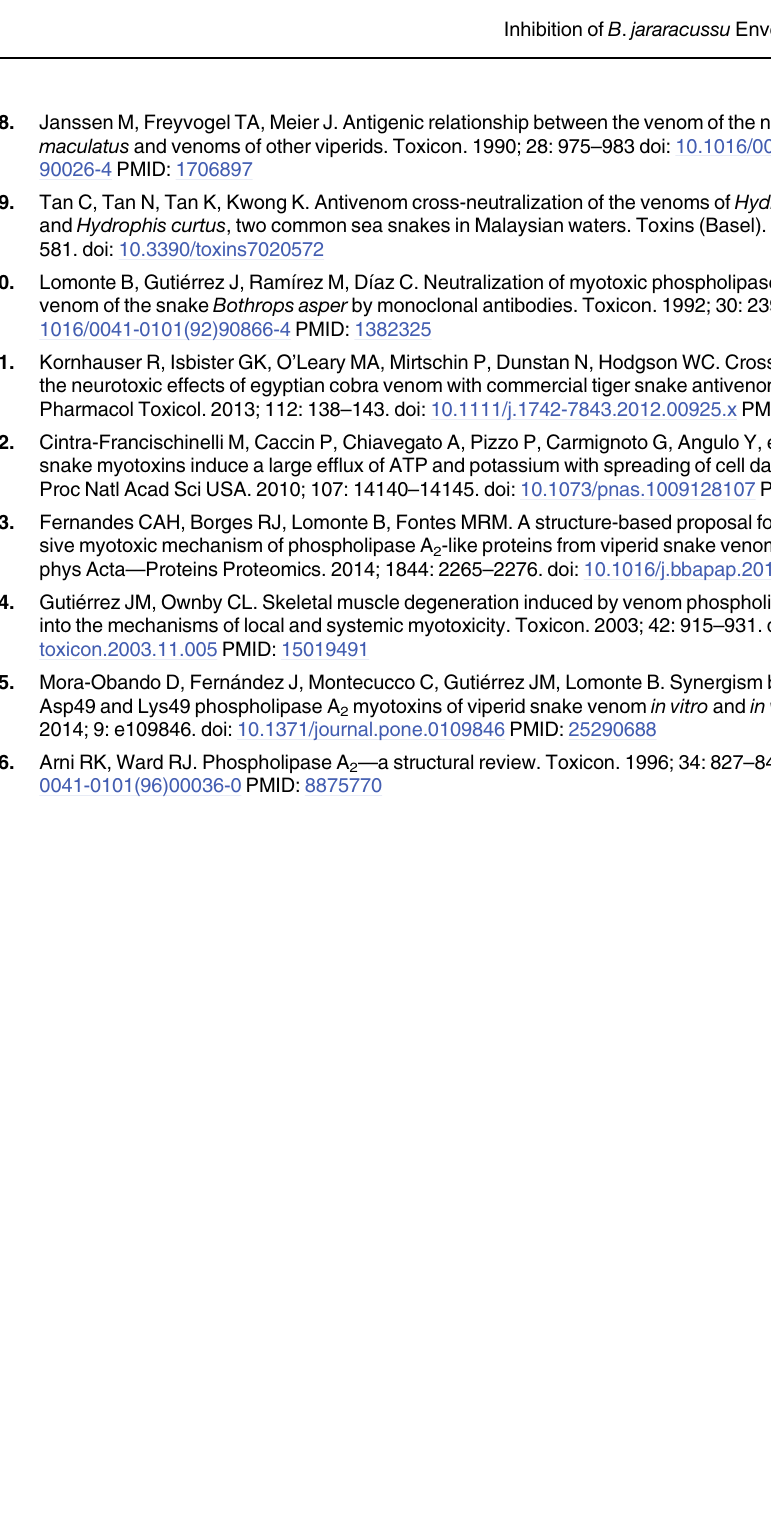
PLOS ONE | DOI:10.1371/journal.pone.0151363 March 30,